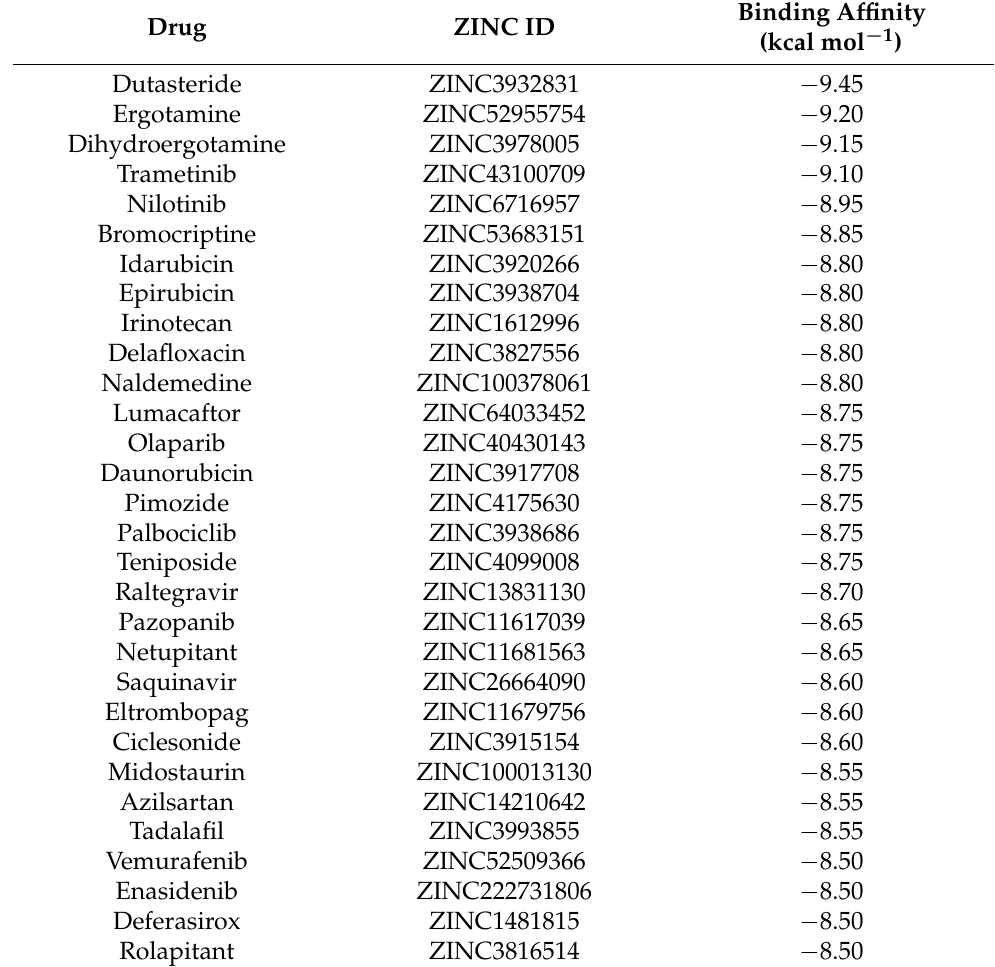
Table 2. Highest score drugs obtained in molecular